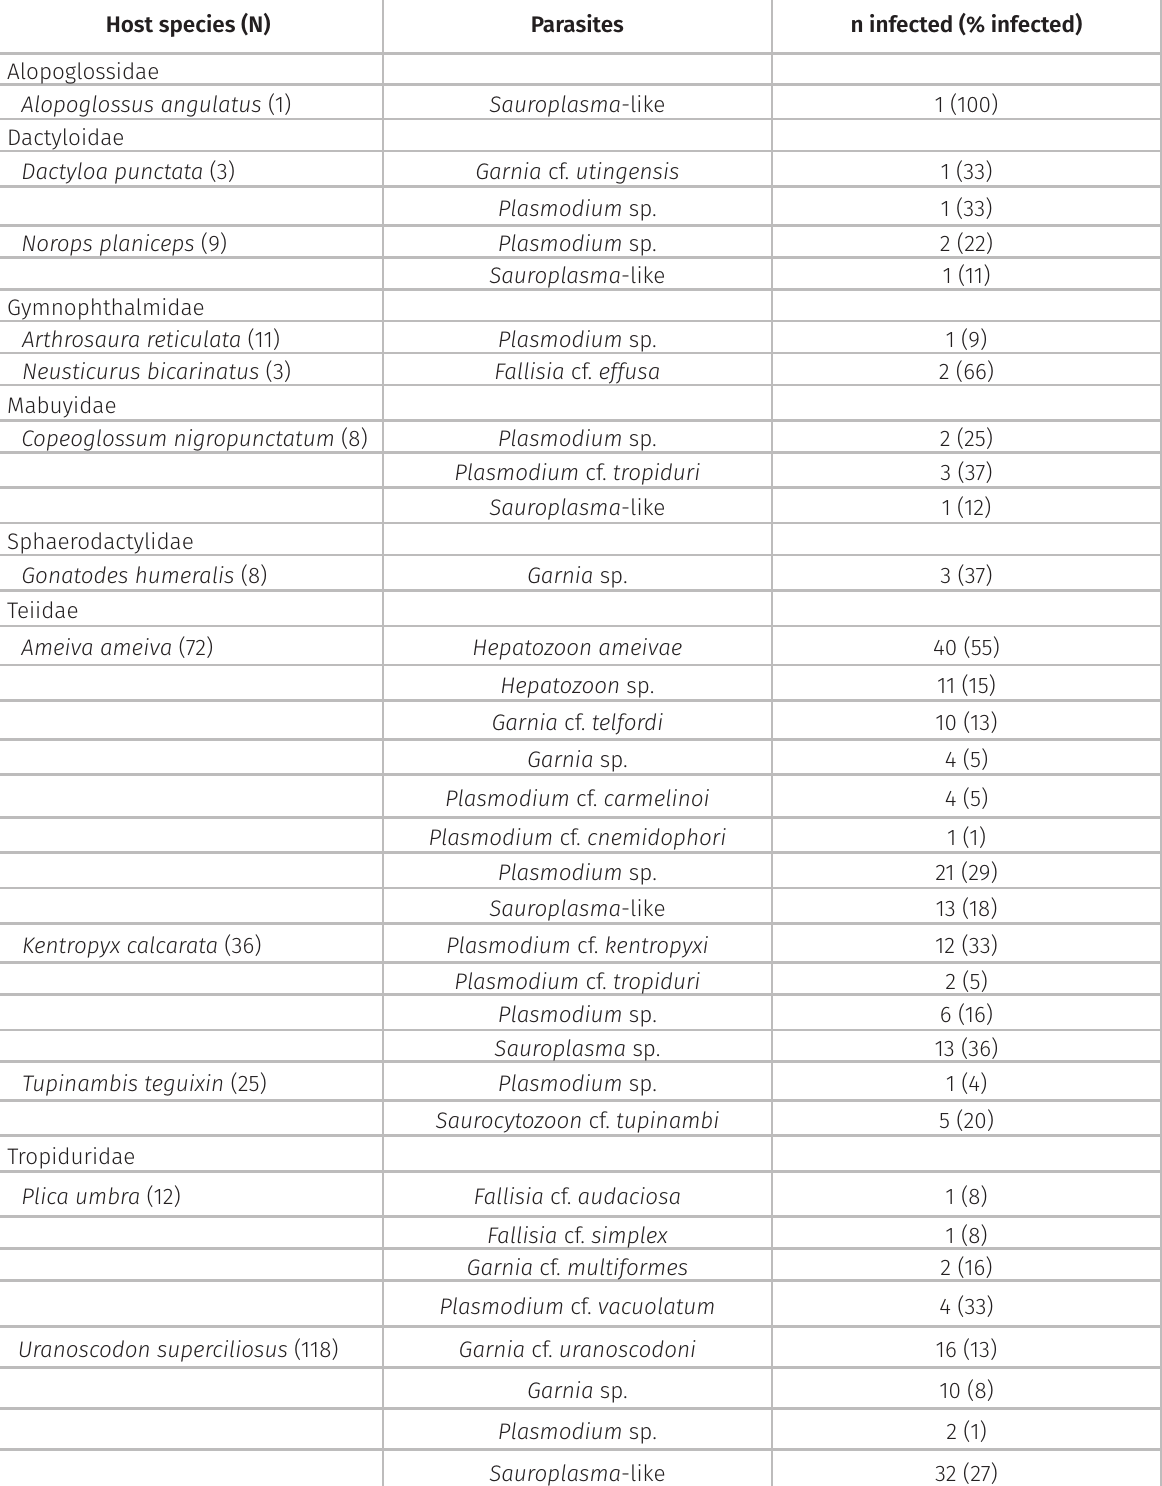
Table III. Infections of Apicomplexa parasites in 12 lizard species sampled in this study. Host species